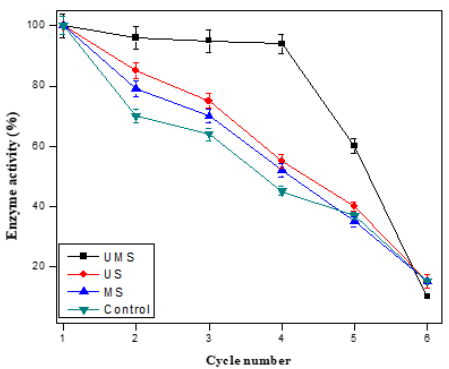
Figure 7. Reusability of the immobilized enzyme generated with and without UMS treatment.